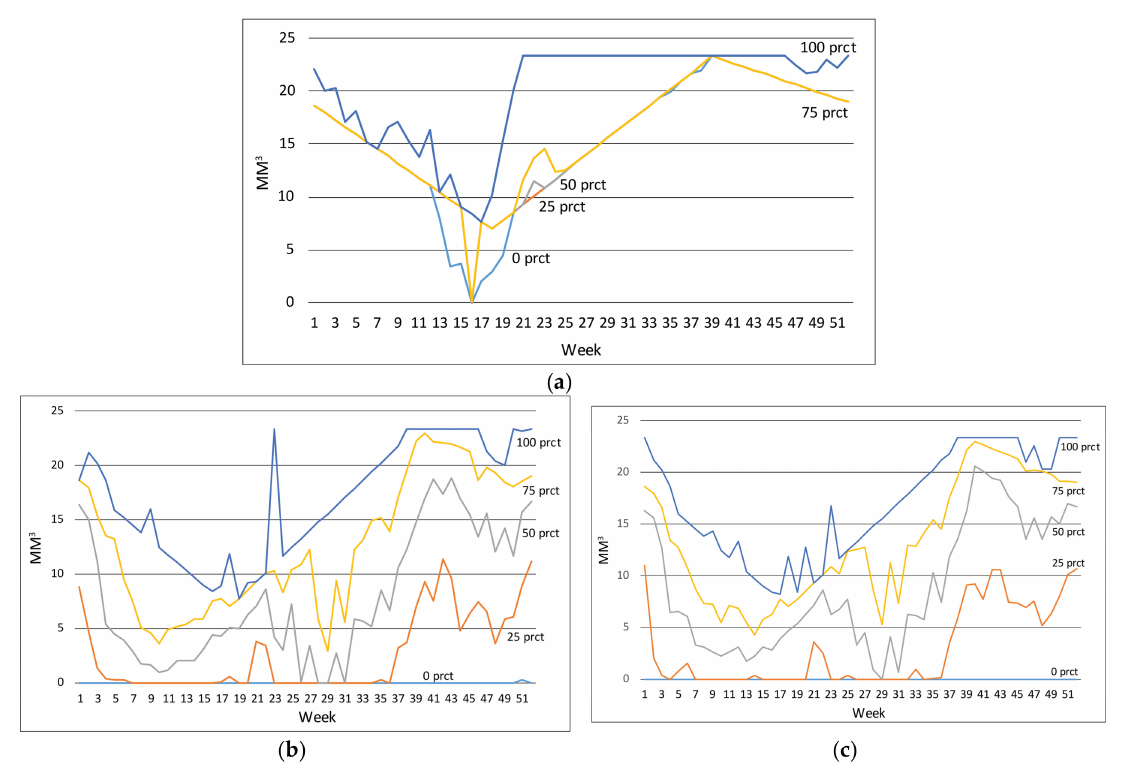
Figure 6. Percentiles (0, 25, 50, 75, 100) reservoir level week-by-week over the year for Lysebotn buffer reservoir (max 23.3 MM 3 ): ( a ) Present hydropower generation capacity (0 GW extra); ( b ) 1.4 GW extra capacity in plant downstream to the reservoir (11 GW extra in Norway); ( c ) 1.8 GW extra capacity in plant downstream to the reservoir (19 GW extra in